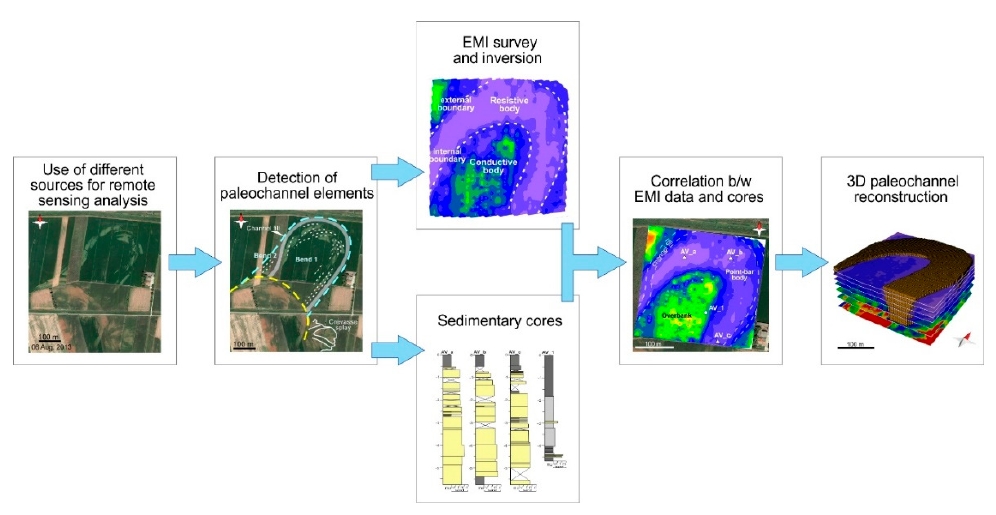
Figure 11. Workflow of the overall methodology adopted in this study.